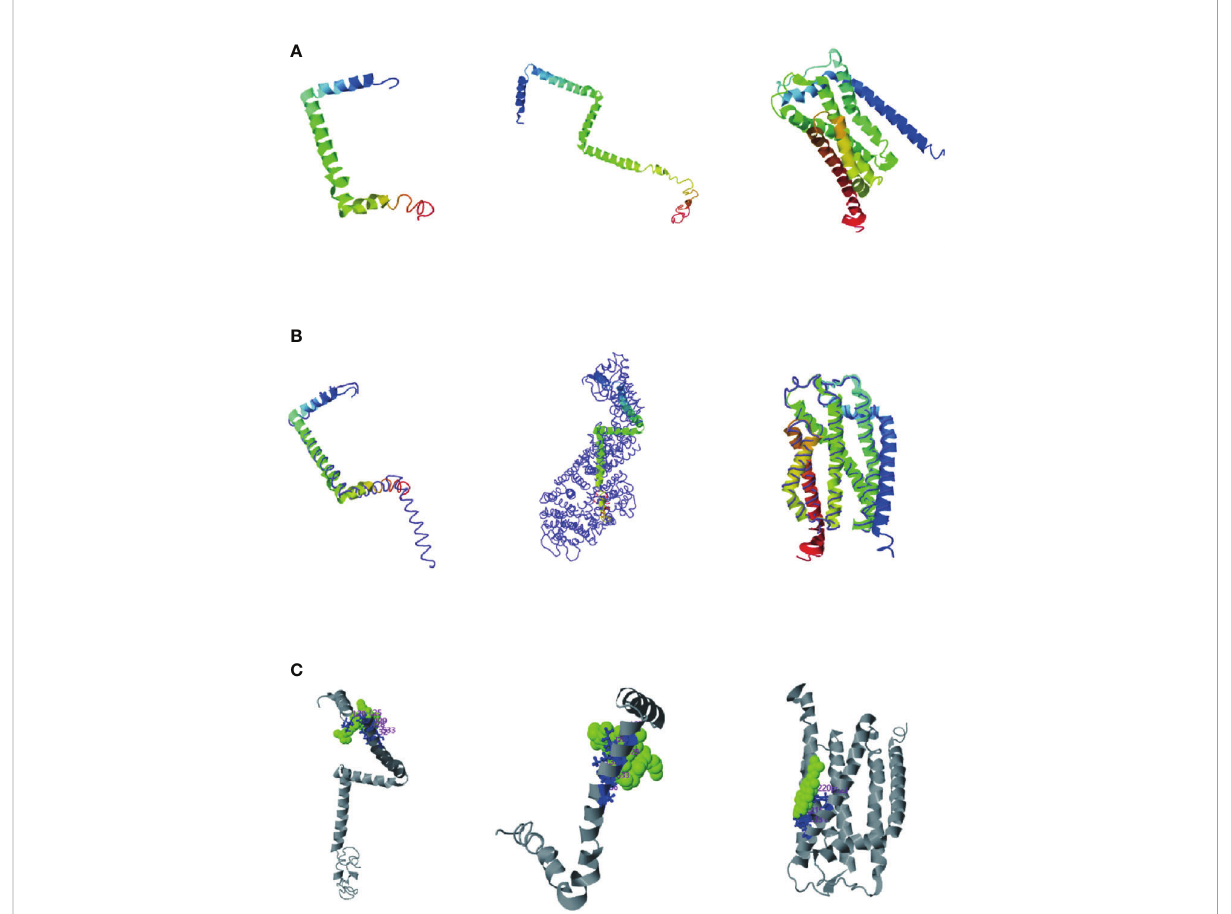
FIGURE 5 (A) Cluster protein structure model with the highest C-score value; (B) Proteins structurally close to the target in the PDB (as identi fi ed by TM- align); (C) COFACTOR and COACH analysis the ligand-binding site; The thin lines represent the backbone of the experimental structures, and the thick lines are the threading templates or the fi nal models. Blue to red runs from N- to